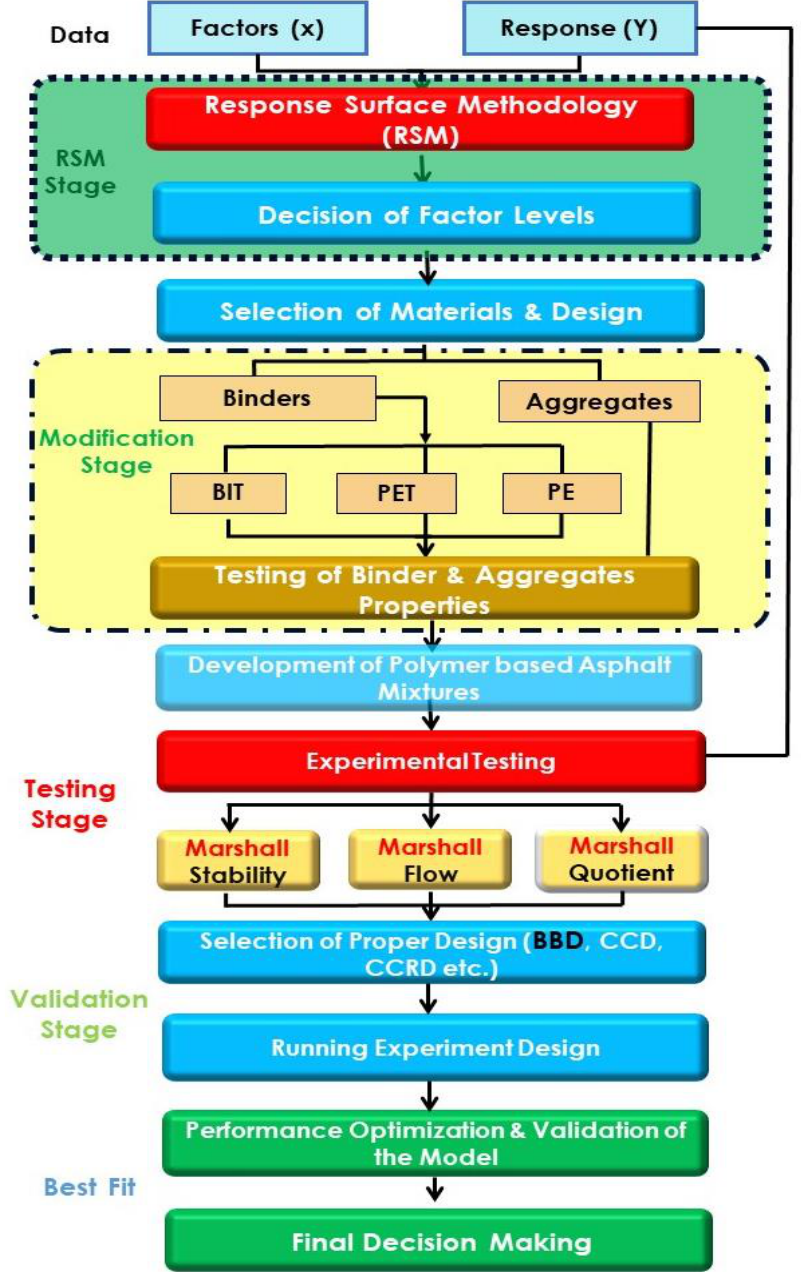
Figure 3. Flow chart of research methodology.